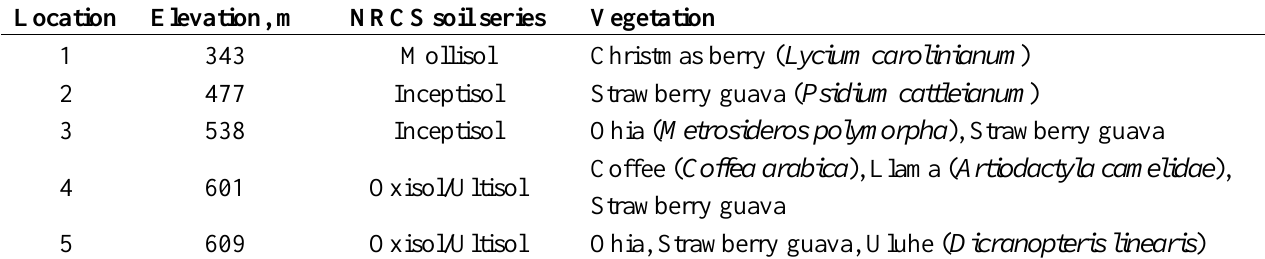
Table 1. The elevation, NRCS soil series, and the vegetation of the five monitoring